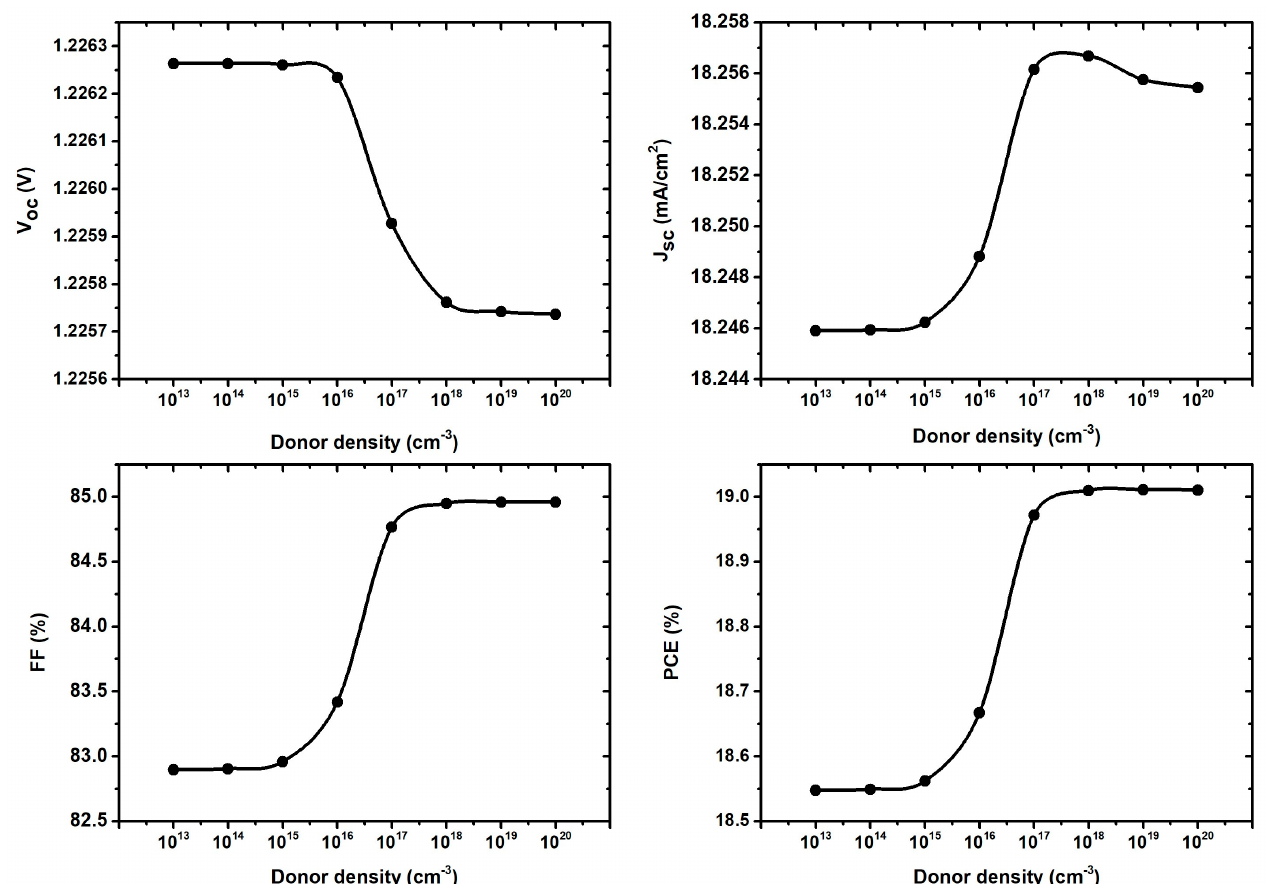
Figure 10. Variation in the PV parameters by increasing the buffer layer doping density.